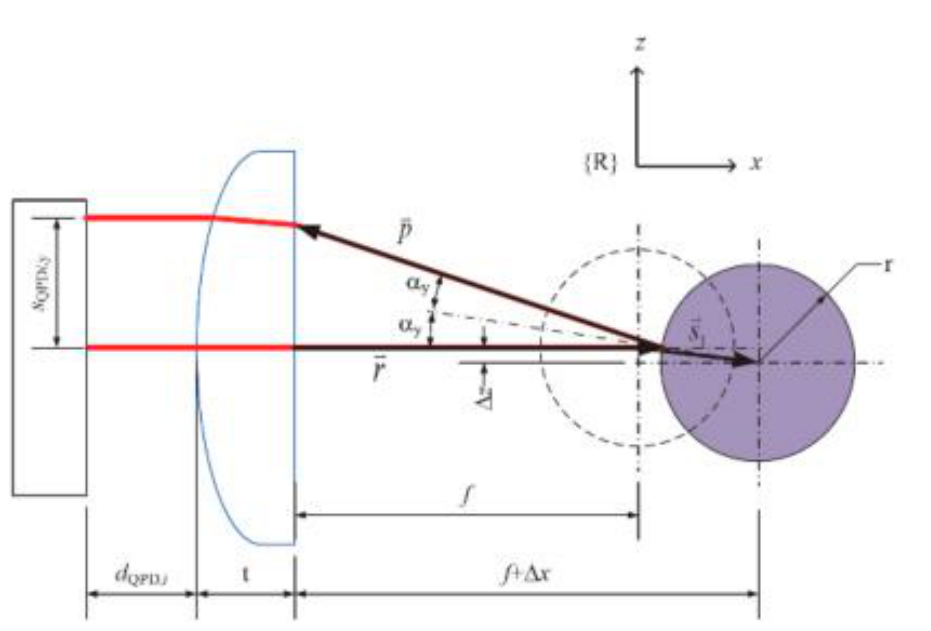
Figure 39. Mathematical model for the measurement modules [33].